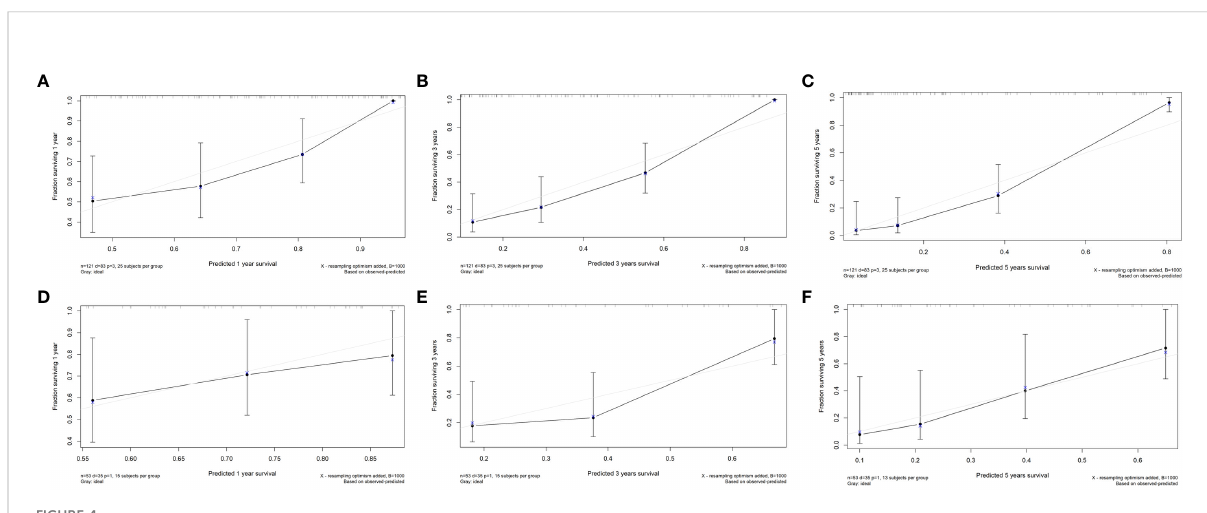
FIGURE 4 The calibration curves of the radiomics nomogram. (A) Calibration curve for prediction 1-year PFS in the train cohort; (B) Calibration curve for prediction 3-year PFS in the train cohort; (C) Calibration curve for prediction of 5-year PFS in the train cohort; (D) Calibration curve for prediction of 1-year PFS in the test cohort; (E) Calibration curve for prediction of 3-year PFS in the test cohort; (F) Calibration curve for prediction of 5-year PFS in the test